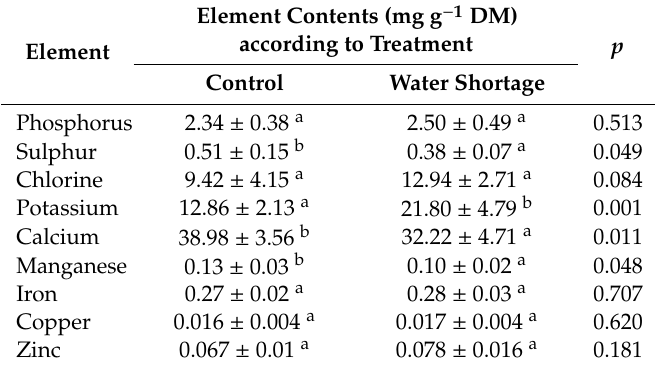
Table 2. Contents of the elements in the buckwheat leaves grown under the control and water shortage conditions.